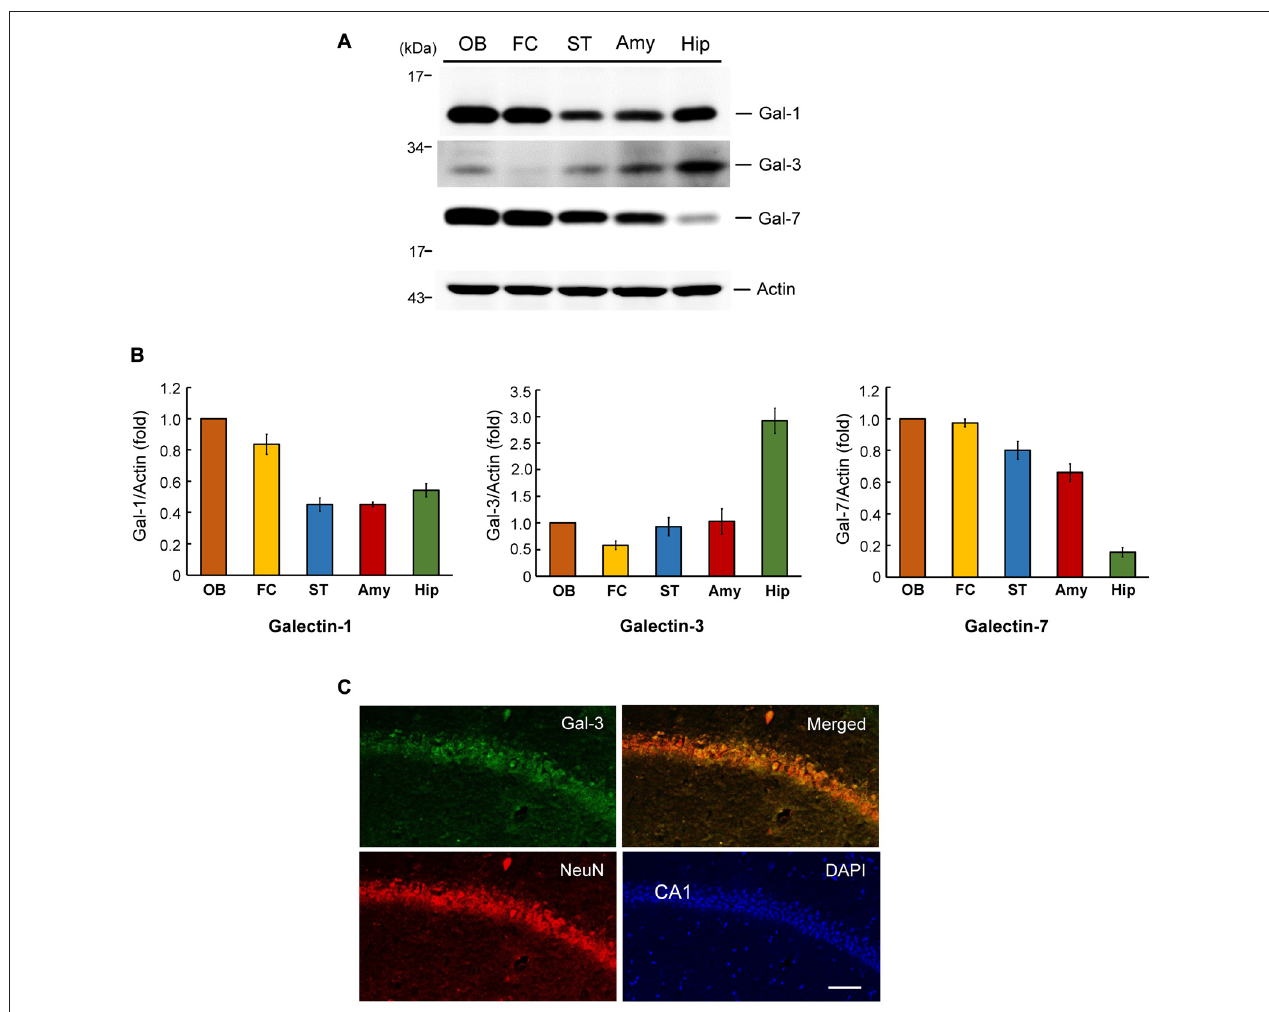
FIGURE 1 | Regional distribution of galectins in the rat brain and endogenous galectin-3 expression in the mouse CA1 area. (A) Western blot analysis showing the expression level of galectin-1, galectin-3 and galectin-7 in several regions in the rat brain. (B) Quantitative analyses of galectin-1, galectin-3 and galectin-7 expression level in different brain regions. N = 4 each group. Gal-1: galectin-1, Gal-3: galectin-3, Gal-7: galectin-7. OB: olfactory bulb, FC: frontal cortex, ST: striatum, Amy: amygdale, Hip: hippocampus. Data are mean ± SEM. (C) Immunohistochemistry showing the distribution of galectin-3, NeuN and their co-localization in rat hippocampal CA1 area. Scale bar equals 50 µ